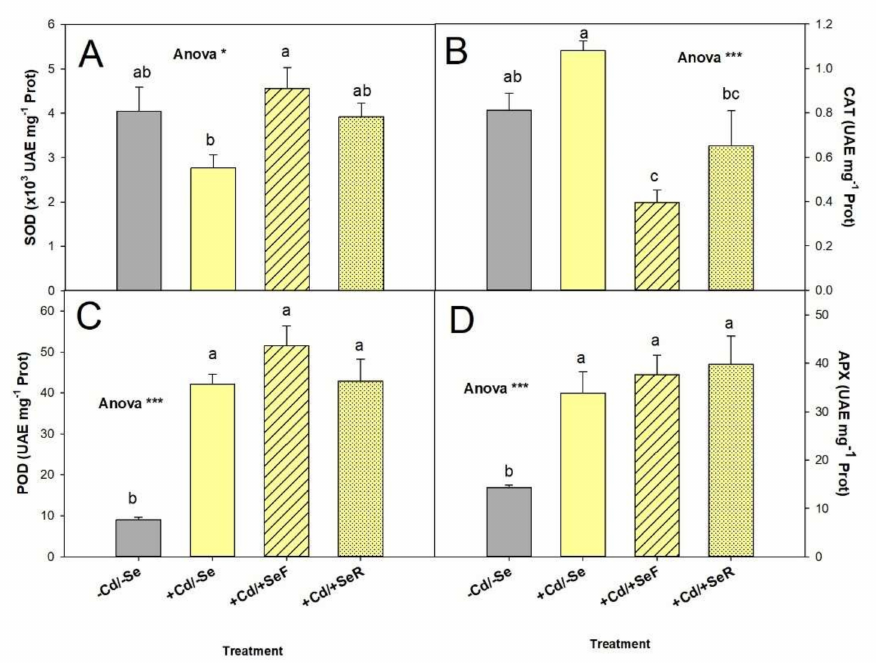
Figure 5. Antioxidant enzymes: superoxide dismutase (SOD, ( A )), catalase (CAT, ( B )), peroxidase (POD, ( C )) and ascorbate peroxidase (APX, ( D )) quantified in leaves from pepper plants under four treatments of cadmium and selenium ( − Cd/ − Se, +Cd/ − Se; +Cd/+SeF and +Cd/+SeR). In the ANOVA: * and *** indicates significant differences for p < 0.05 and 0.001, respectively. The different lowercase letters indicate significant differences between the treatments for p < 0.05 established by Tukey’s multiple range test. The vertical bar indicates the standard error of the mean.